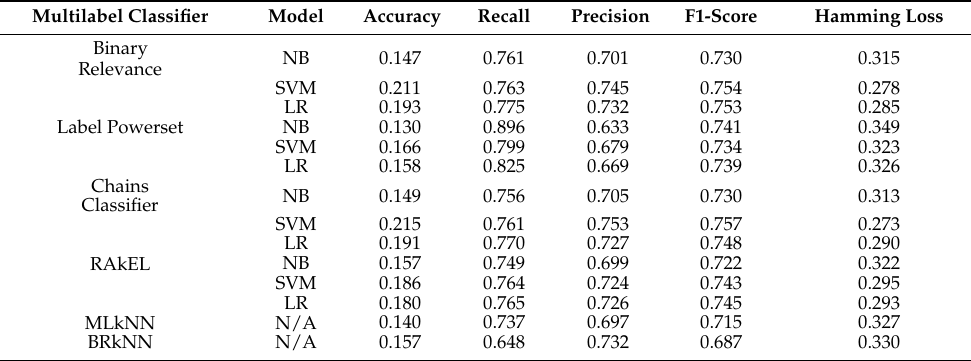
Table 1. Overall ML models performance with 5-fold